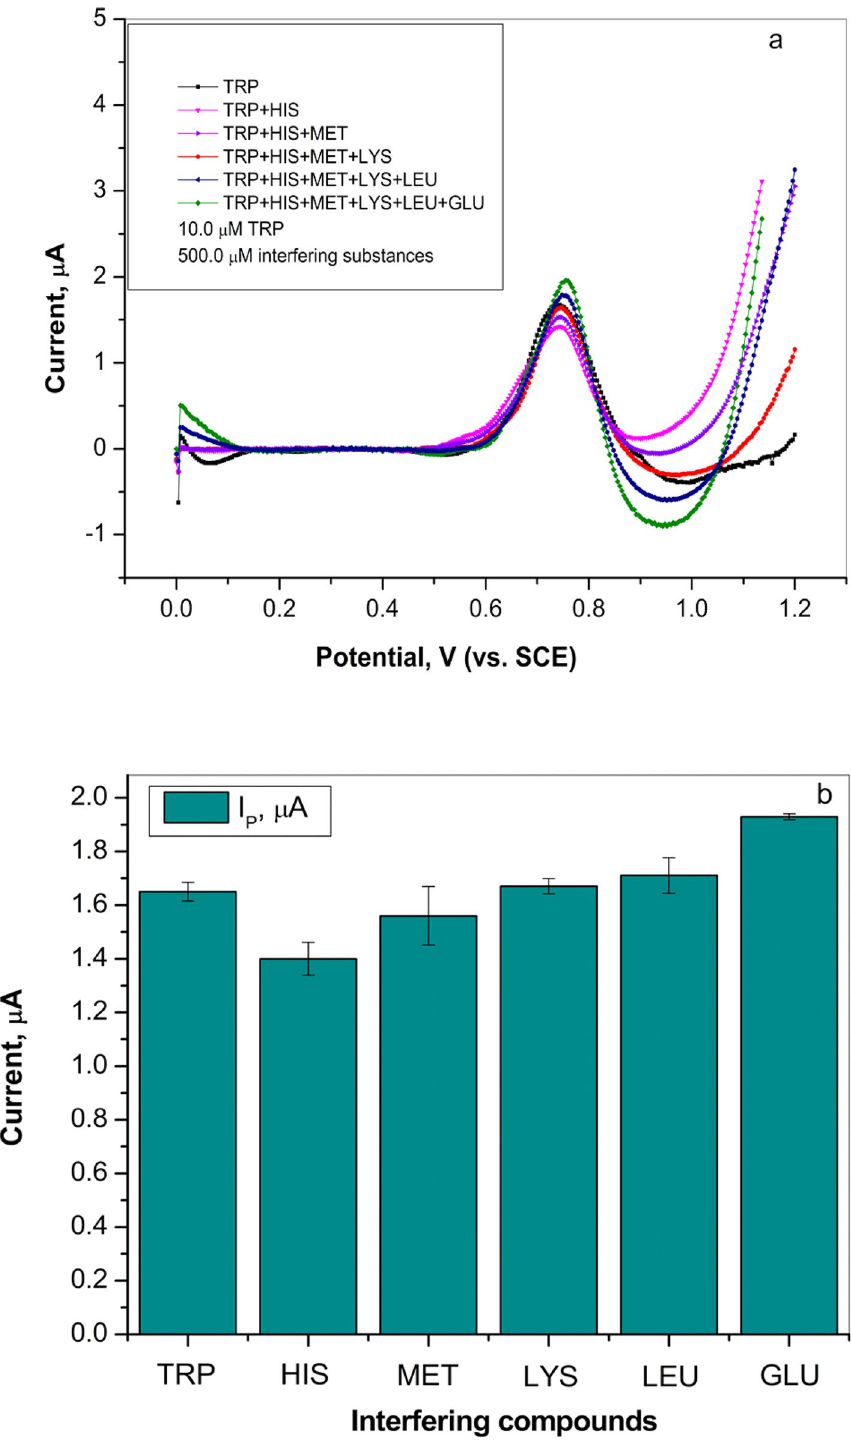
Figure 7. ( a ) Differential pulse voltammetry curves of L-tryptophan (10.0 µM) oxidation in presence of potentially interfering substances (500.0 µM) in Britton–Robinson buffer (pH 4.0) (curves subjected to baseline correction); ( b ) bar diagram between current peak of L-tryptophan in relation to potentially interfering